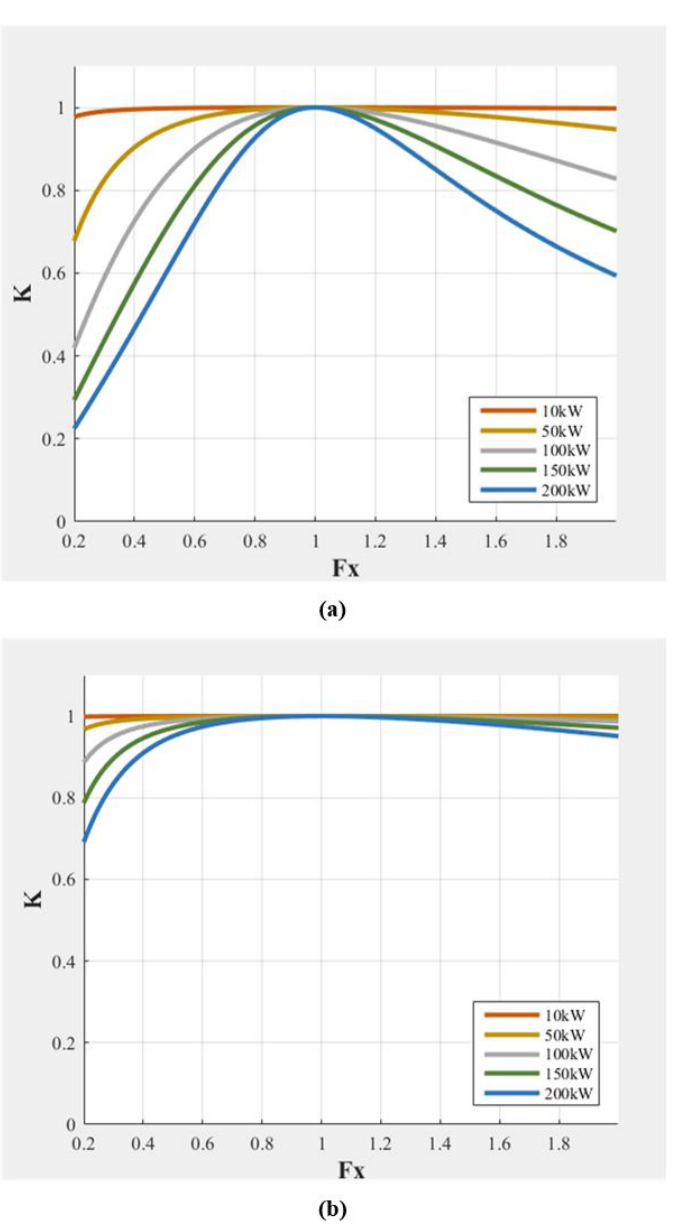
Figure 4. Voltage gain graph of resonant tank with different m value ( a ) C r = 13 µ F, L r = 27 µ H,